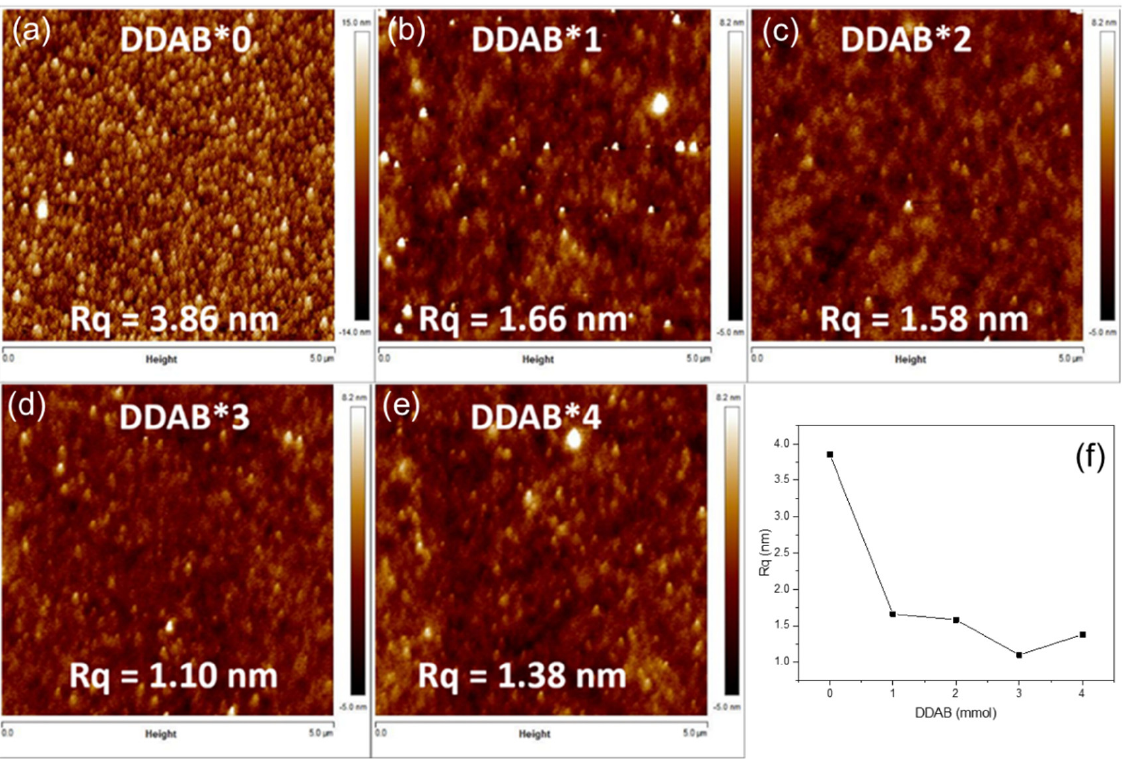
Figure 5. AFM images of the films coated with CsPbCl x Br 3−x PQDs treated by ( a )DDAB*0, ( b )DDAB*1, ( c )DDAB*2, ( d )DDAB*3, and ( e )DDAB*4. ( f ) The root mean square roughness (Rq) of PQD films coated with different DDAB concentrations.